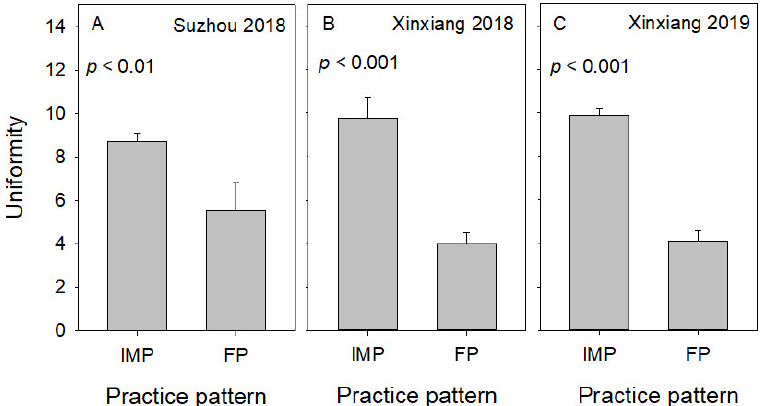
Figure 5. The effects of seeding management practices on developmental uniformity of soybean. IMP, integrated management practice; FP, farmers’ practice. The bottom and top bars of each dataset represent standard error. ( A ) represents the developmental uniformity of soybean at Suzhou site in 2018. ( B ) and ( C ) represent the developmental uniformity of soybean at Xinxiang site in 2018 and 2019, respectively.